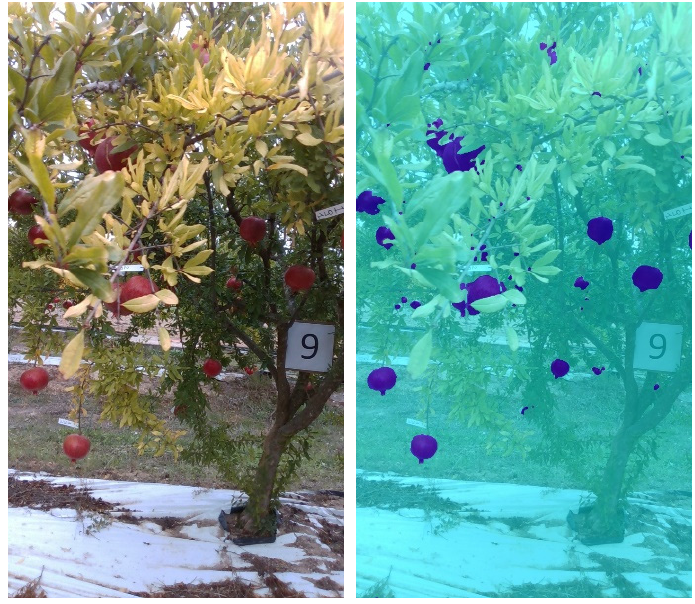
Figure 12. FIA result for the same image as Figure 9. ( Left ): original image; ( right ): segmentation result.